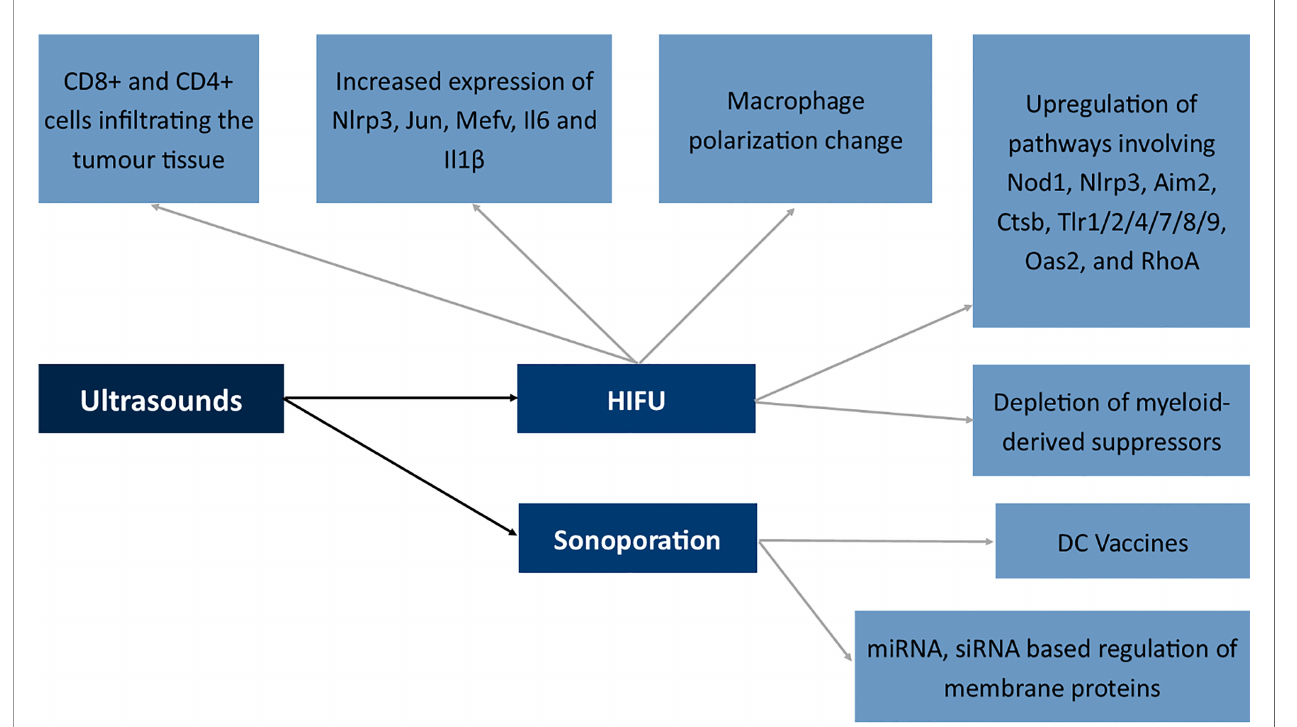
FIGURE 8 | Effects of ultrasounds on the expression of membrane antigens. NLR Family Pyrin Domain Containing 3 (Nlrp3), Jun Proto-Oncogene (Jun), Mediterranean fever gene for marenostrin (MEFV), Dendritic cell (DC), Nucleotide-binding oligomerization domain-containing protein 1 (Nod1), Absent In Melanoma 2